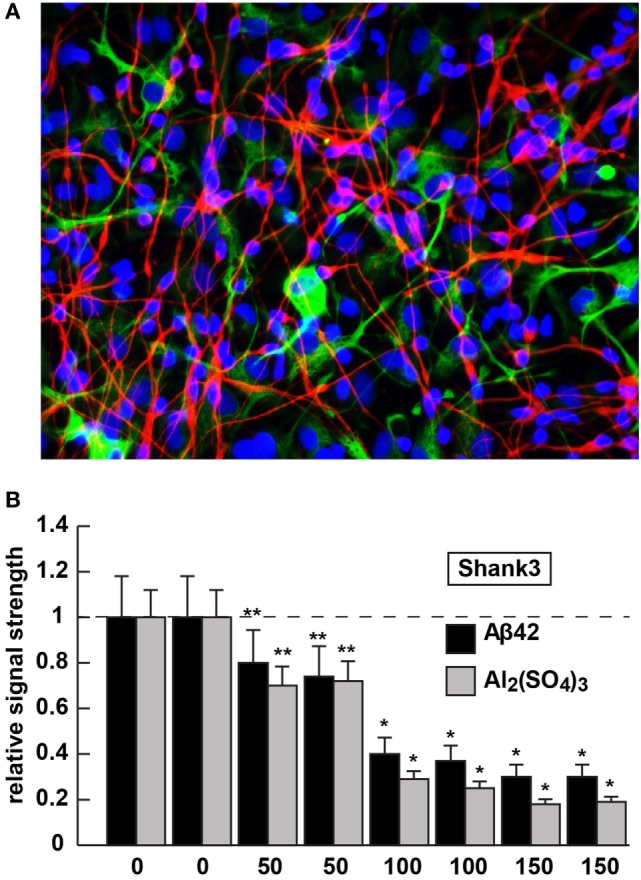
Shank3 downregulation in 42 amino acid amyloid-beta (Aβ42) peptide- or aluminum sulfate [Al2(SO4)3]-stressed human neuronal–glial (HNG) cells in primary coculture; (A) 2-week-old HNG cocultures (approximately 60% neurons and 40% astroglia) stained with the neuron-specific marker β tubulin 3 (red signal; λmax ~680 nm) or the astroglial-specific marker GFAP (green signal; λmax ~550 nm); HNG nuclei have been also stained with DAPI (blue; λmax ~430 nm); culture of HNG cells has been previously described in detail by our laboratory (19, 41, 42); human brain neurons do not culture well without the presence of astroglial cells; magnification 40×; HNG cocultures were incubated with Aβ42 peptide (0, 50, 100, or 150 nM for 36 h) or ultrapure aluminum sulfate [Al2(SO4)3; 0, 50, 100 or 150 nM for 36 h]; these concentrations of stressors and times were selected from previous reports of Aβ42 peptide- and aluminum sulfate-induced inflammatory neurodegeneration and other relevant reports on neurotoxicity toward HNG cells, human brain microvessel endothelial cells that line the cerebral vasculature and other brain cell types (25–27, 36, 42–47); methodologies involving the application of Aβ42 peptide- or aluminum sulfate as physiologically realistic stressors to HNG cells in primary coculture have been explained in detail in previously published reports from our laboratory (11, 36, 42, 45–47); HNG whole-cell protein extracts were prepared, and Shank3 abundance was quantified using Western analysis and ImageQuant as described in Figures 1A,B (10, 36, 37, 43); (B) results are quantified in bar-graph format; at 100 nM Aβ42 peptide- or aluminum sulfate-treatment Shank3 levels were reduced between 0.2- and 0.3-fold of untreated control values; N = 3–5 samples of each treatment or condition; in Figure 2B, a dashed horizontal line at 1.0 has been included for ease of comparison; bars represent the mean ± 1 SD; *p < 0.01; **p < 0.05 (ANOVA).